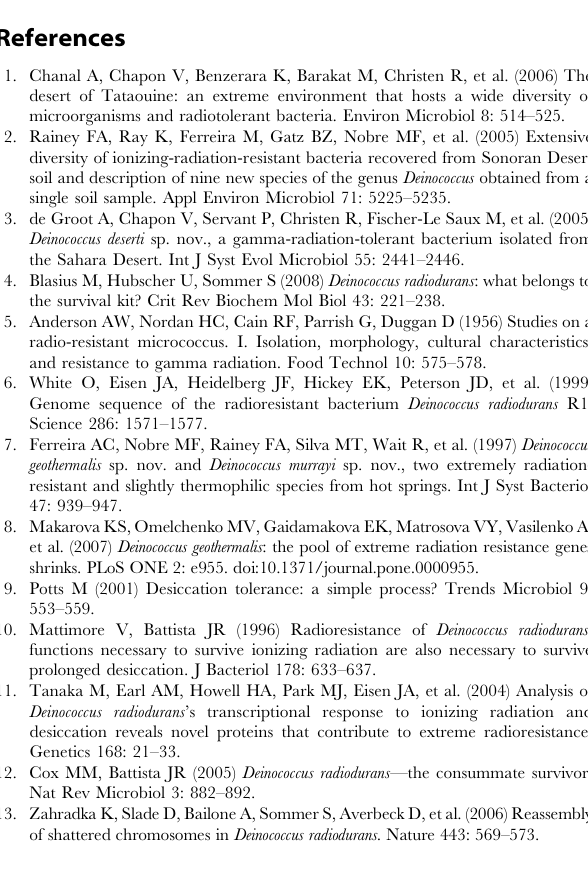
Figure S5 Genome dot plots for the chromosomes of sequenced Deinococcus species. Genome dot plots for the chromosome of D. deserti (horizontal axis) vs. D. geothermalis (vertical axis) (A) and vs. D. radiodurans (vertical axis) (B). Each dot represents the location of a pair of Bidirectional Best Hits (with a minimum of 30% identity and 70% coverage) between the two chromosomes. Table S1 Insertion sequences identified in the genome of D. deserti and comparison with other Deinococcus / Thermus species. Table S2 Proteins identified by LC-MS/MS shotgun. Table S3 Peptides identified by LC-MS/MS shotgun. Table S4 Homology between the DNA molecules of D. deserti , D. radiodurans and D. geothermalis . Table S5 Deinococcus -specific proteins. Table S6 Mn/Fe ratio in D. deserti and D. radiodurans . Table S7 Mn- and Fe- transport and regulation related systems in D. deserti .